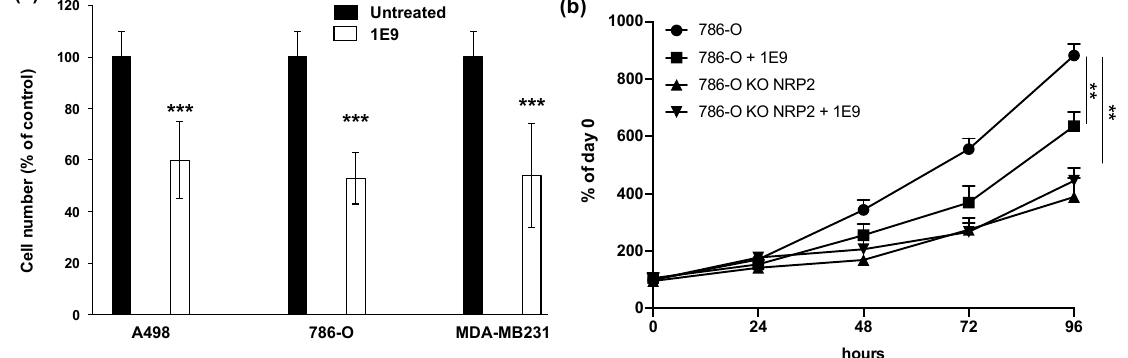
Figure 3. 1E9 antibodies inhibit the proliferation of kidney and breast tumor cells expressing VEGFC and its receptor/co-receptor through NRP2 signaling. ( a ) Kidney (A498, 786-O) and breast (MDA-MB231) cancer cells’ proliferation were assessed by MTT assays after 48 h of incubation with 10 µg/mL of purified 1E9 antibodies in DMEM medium containing 2% fetal bovine serum. The three independent cell lines expressed high amounts of VEGFC (around 1 ng/mL/10 6 cells). Kidney cells expressed the VEGFC co-receptors Neuropilin 1 and Neuropilin 2, and the MDA-MB231 expressed Neuropilin 1 and, to a lesser extent, Neuropilin 2. ( b ) Proliferation curves of 786-O and 786-O_KO_NRP2 cells. Cells were incubated with 1E9 antibodies and counted at the indicated times. ** p < 0.01, *** p < 0.001.